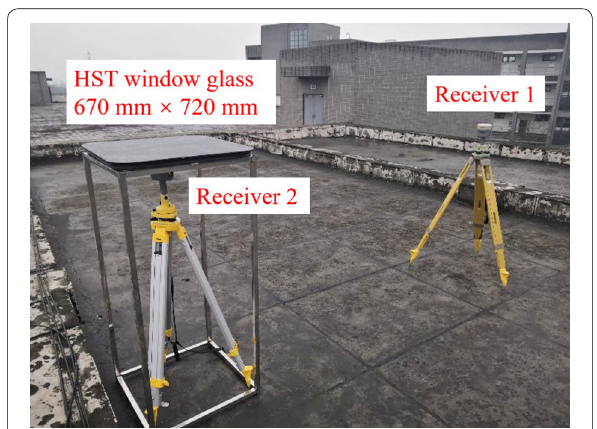
Fig. 1 Two GNSS receivers were placed on a building rooftop on the campus of Southwest Jiaotong University, Chengdu, China on 9 March 2019. During period 1 (GPS time 3:00:00–9:00:00), receiver 1 was in the open-sky observation environment (right) and an HST window glass was placed over the antenna of receiver 2